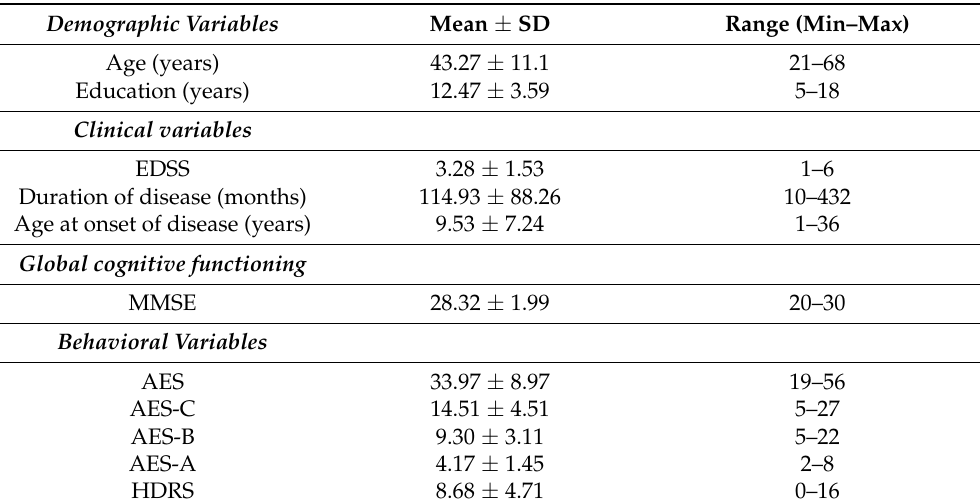
Table 1. Demographic, behavioral, and clinical variables (Mean ± Standard Deviation) of participants with MS ( n = 85).